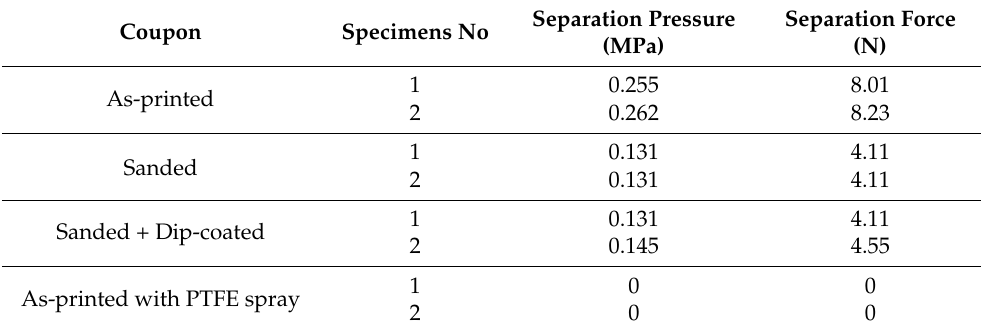
Table 6. Adhesion test quantitative